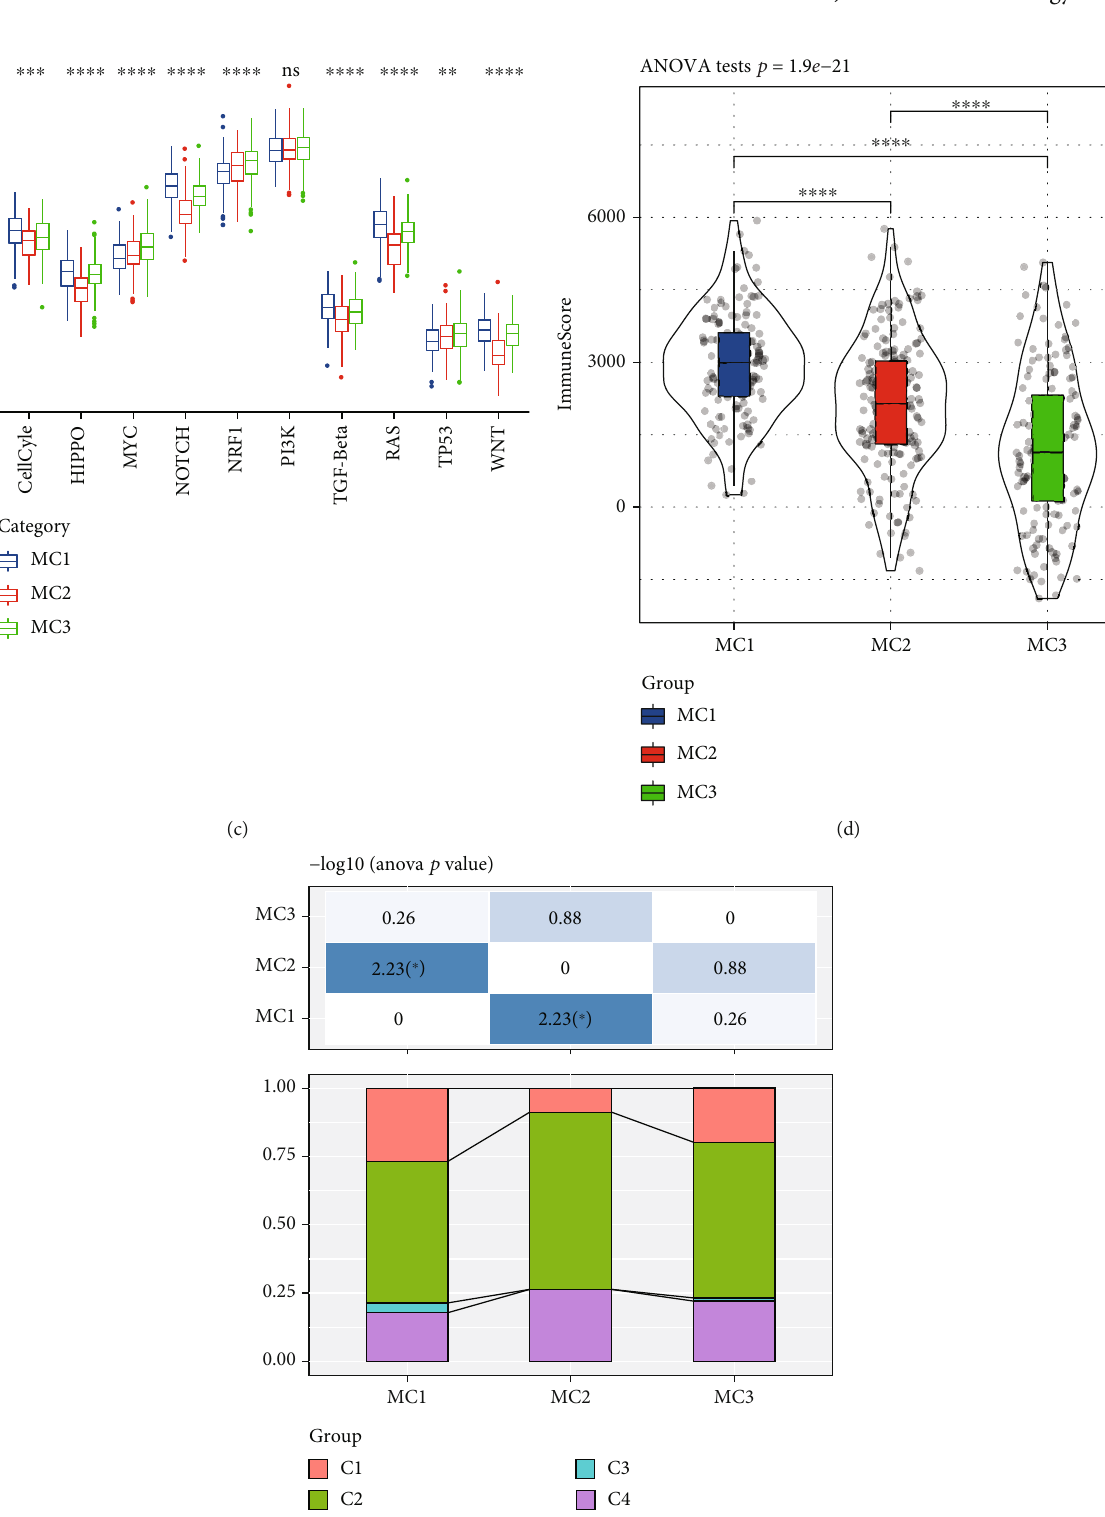
Figure 4: (a) Ratio of 22 immune cell components in the di ff erent subgroups. (b) Di ff erences in 22 immune cell components of samples among the di ff erent subgroups. (c) Di ff erences in the scores of 10 pathways related to tumor abnormalities among the di ff erent subgroups. (d) Di ff erences in the immune in fi ltration scores among the di ff erent subgroups. (e) Comparison of the three metabolic molecular subtypes with the previous six pancancer metabolic molecular subtypes. ANOVA test was conducted among three groups. ns: no signi fi cance. ∗ P < 0 : 05 , ∗∗ P < 0 : 01 , ∗∗∗ P < 0 : 001 , and ∗∗∗∗ P < 0 : 0001